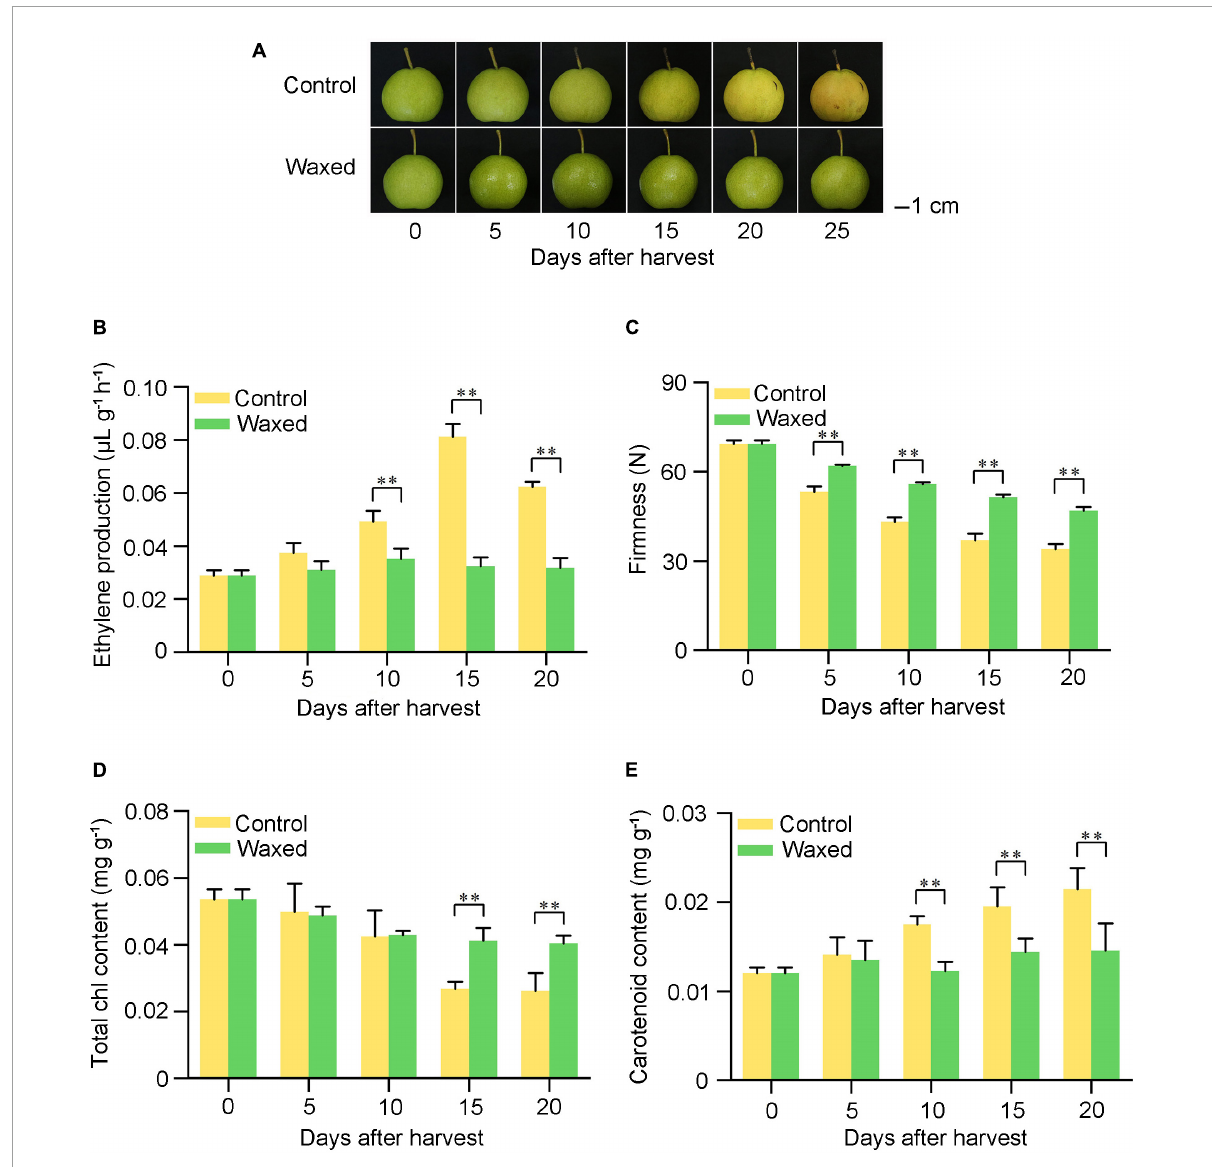
FIGURE6 Postharvest wax coating treatment inhibits pear fruit ripening. Pear fruit were collected on the commercial harvest day (135 DAFB) in 2020 and storage at room temperature for 25 days (A) . After treatment, ethylene production (B) , fruit firmness (C) , total Chl content (D) , and carotenoid content (E) were measured. Control, pear fruit not receiving treatment; Waxed, fruit treated with morpholine fatty acid salt fruit wax. Scale bar = 1 cm. The x-axis represents days of storage at room temperature after harvest. Five bioligical replicates were analyzed for ethylene production, fruit firmness, and three bioligical replicates for total Chl content and carotenoid content. Values represent mean ± SE. Statistical significance was determined using a Student’s t -test, and ∗∗ p <